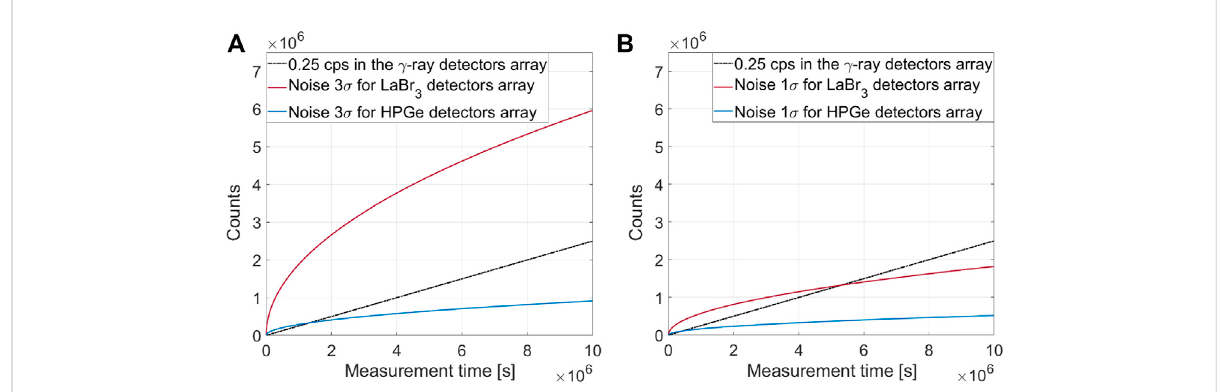
FIGURE 8 Trendofthecounts oftheexpectedsignal (inblack),considering arateof0.25 cps (countspersecond)inthemultidetectorarray,andofthe3 σ background level (A) for LaBr 3 and HPGe detectors (in red and blue, respectively). (B) Similar plot as in (A) for a rate of the 1 σ background levels.